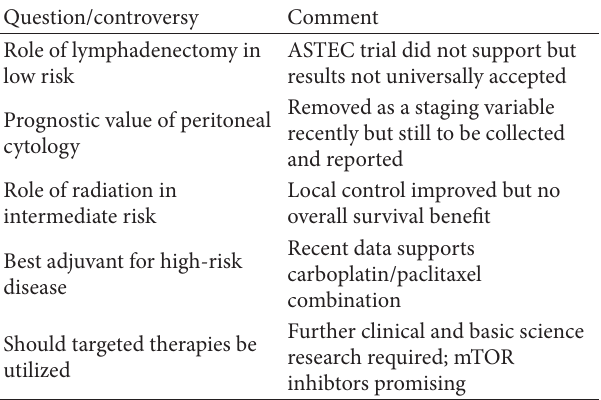
Table 11: Selected treatment controversies in endometrial